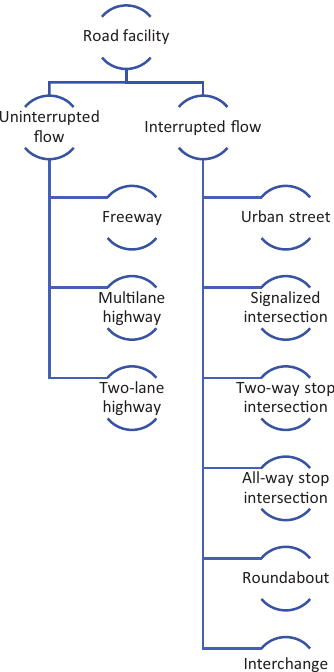
Figure 1. Classification of road facilities by